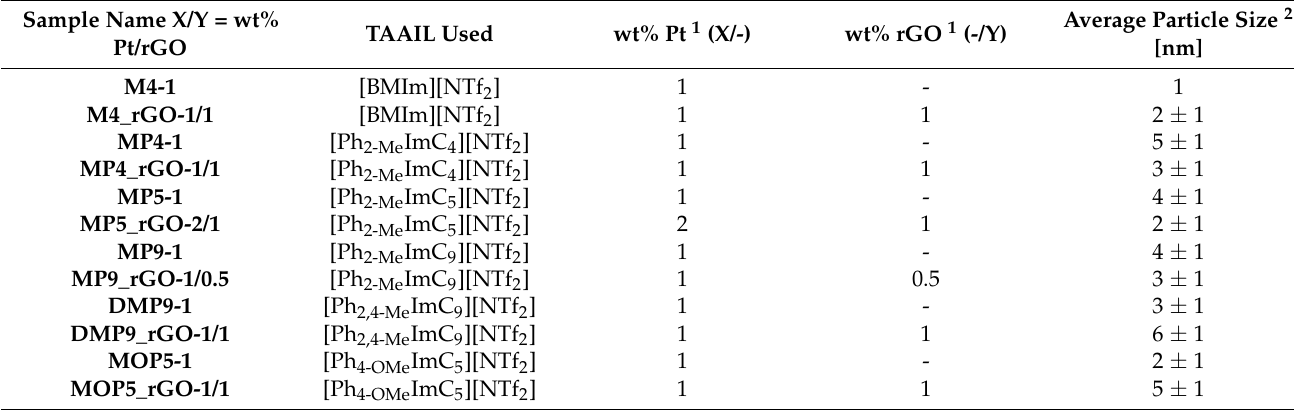
Table 1. Summary of Pt-NPs and Pt-NP@rGO in tunable aryl alkyl ionic liquids (TAAILs). Further information can be found in Table S1 in the Supplementary Information.